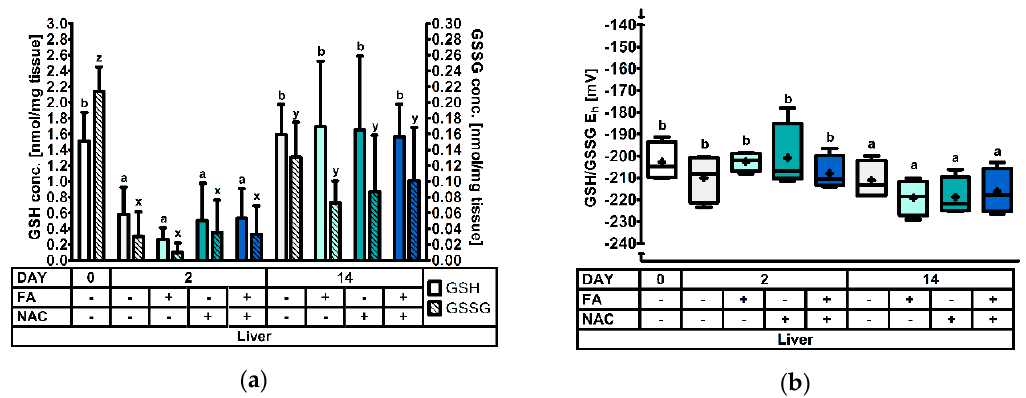
Figure 3. The glutathione redox system in liver tissue of piglets at 0d, 2d, and 14d post-weaning (DAY), either ad libitum fed (FA − ) or fasted (FA+) the first 2d post-weaning, and either provided standard drinking water (NAC − ) or water supplemented with 200 mg/L N -acetyl cysteine (NAC+) during the